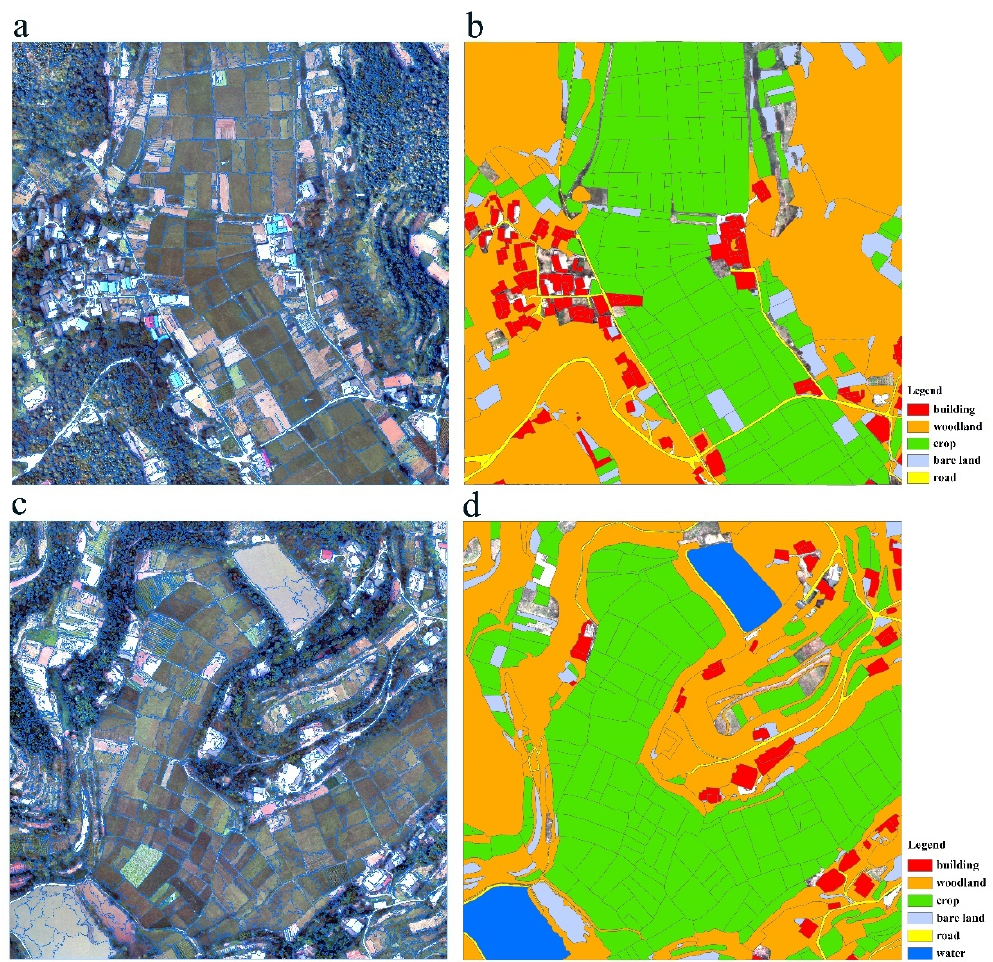
Figure 1. Study area in the southwest of China showing the plot acquired by the UAV images. ( a ) Digital ortho image of area 1 overlaying a segmentation layer at a scale of 100; and ( b ) the reference layer. ( c ) Digital ortho image of area 2 overlaying a segmentation layer at a scale of 100; and ( d ) the reference layer.